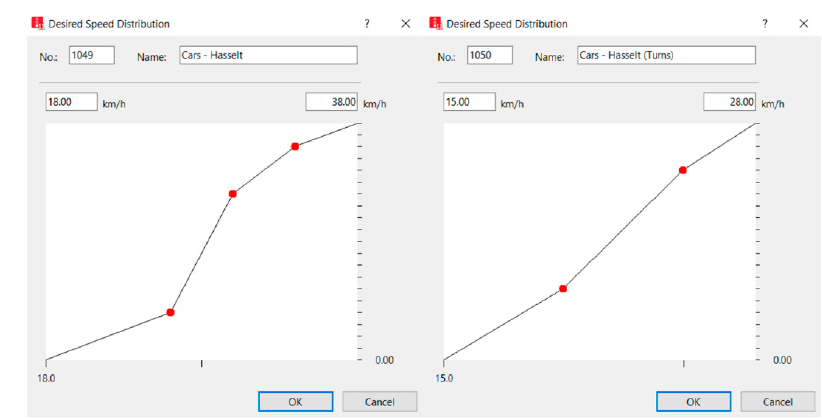
Figure 7. Implemented speed distributions for cars for normal routes ( left ) and turns ( right ).